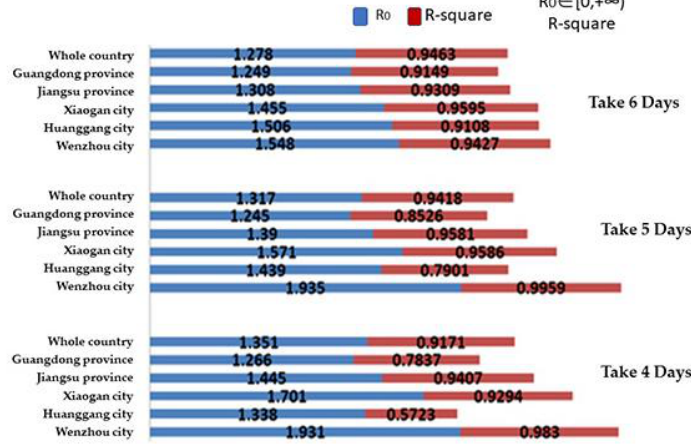
Figure 5. The evaluation results of R 0 and the corresponding R-square